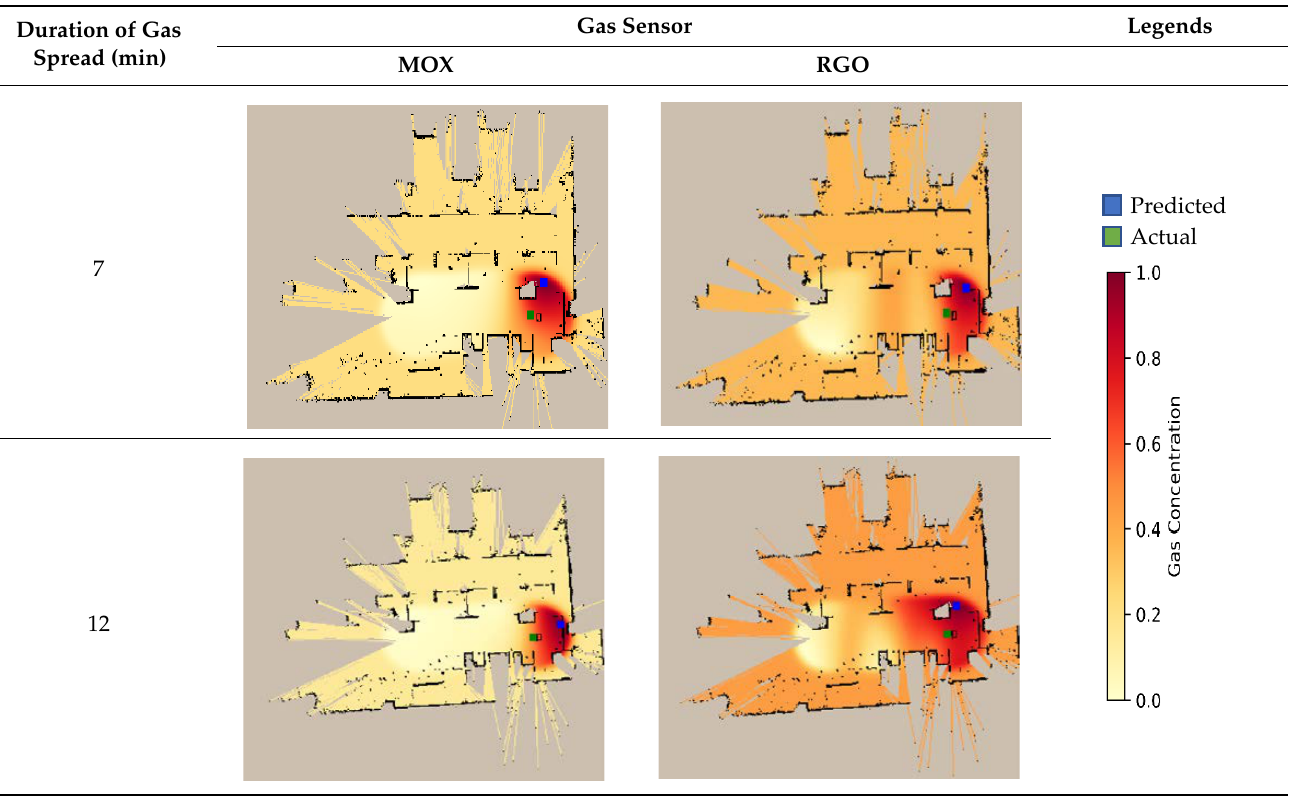
Table 2. Mean gas concentration SLAM-GDM Map with actual and predicted gas source location.